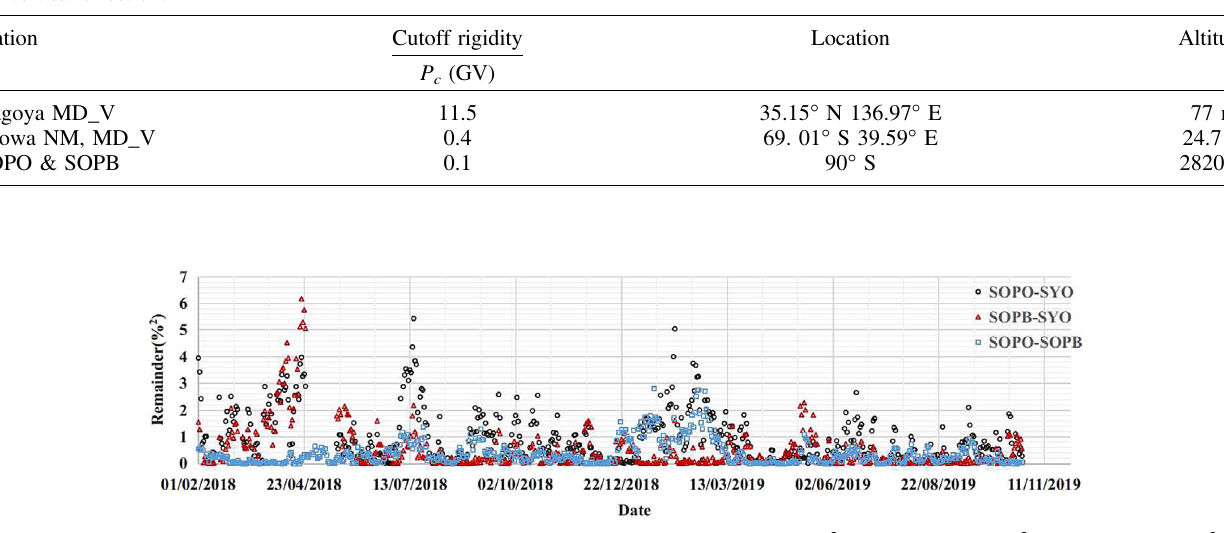
Fig. 8. The squared difference between variations observed by three NMs. (SOPO-SYO_NM) 2 , (SOPB-SYO_NM) 2 and (SOPO-SOPB) 2 are shown by black open circles, red open triangles and blue open squares, respectively. Differences became smaller after 2019, except in several short periods. Minor tick marks on the horizontal axis are indicated every 27 days.